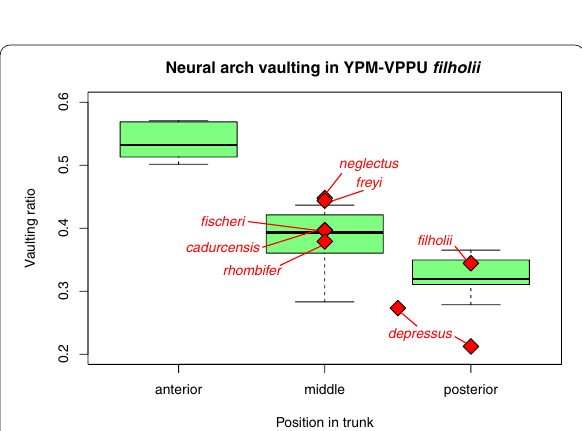
Fig. 90 Vaulting ratio in anterior, mid- and posterior trunk vertebrae in the YPM sample of Phosphoroboa filholii comb. nov. compared to same ratio in type material of various Paleogene constrictors from Europe. Two types are plotted for Paleryx depressus (junior synonym of Paleryx rhombifer ) because one vertebra is close to the mid-/posterior trunk boundary, and moving it to the one or the other column